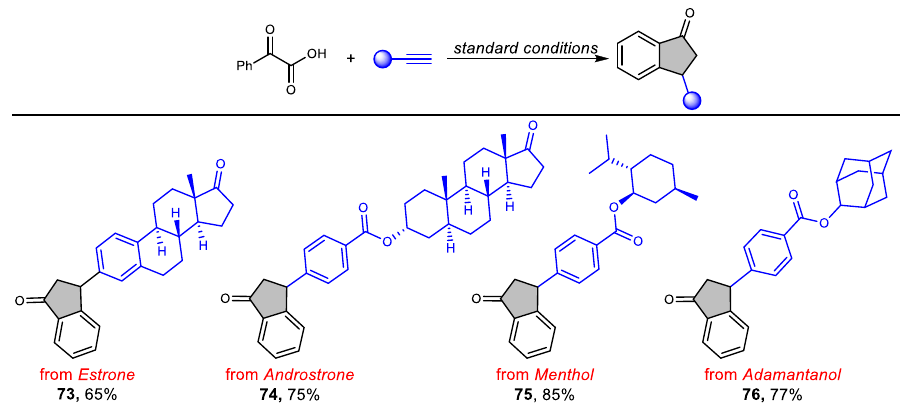
Fig. 4 Late-stage functionalization of complex molecules. Reactions conditions: acid (1.0 mmol), alkyne (0.5 mmol), Ir[dF(CF 3 )ppy] 2 (phen)PF 6 (1 mol%),